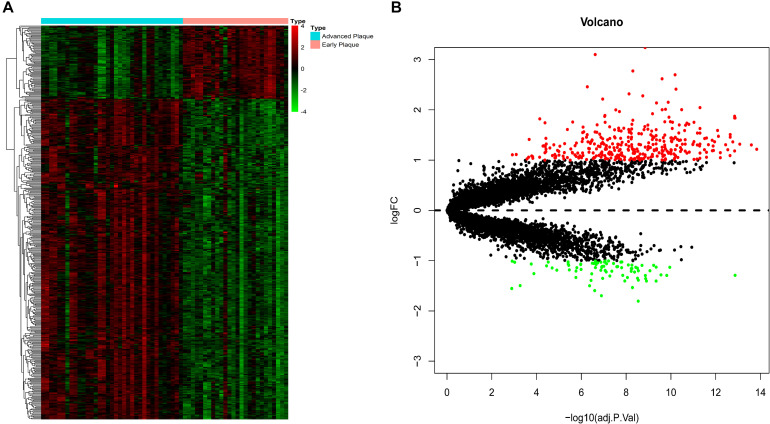
DEG screening. (A) Heatmap. The heatmap showed the expression pattern of genes. (B) Volcano plot. The x-axis represents the -log10(adj.P.Val) while they-axis represents log2(fold-change). The red dots represent up-regulated DEGs while the green dots represent the down-regulated DEGs.